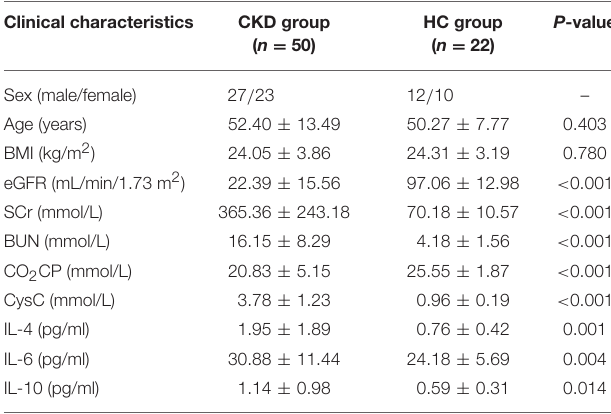
TABLE 1 | Clinical characteristics and inflammatory cytokine levels exhibited by patients with chronic kidney disease (CKD) and healthy control subjects (HC). Clinical